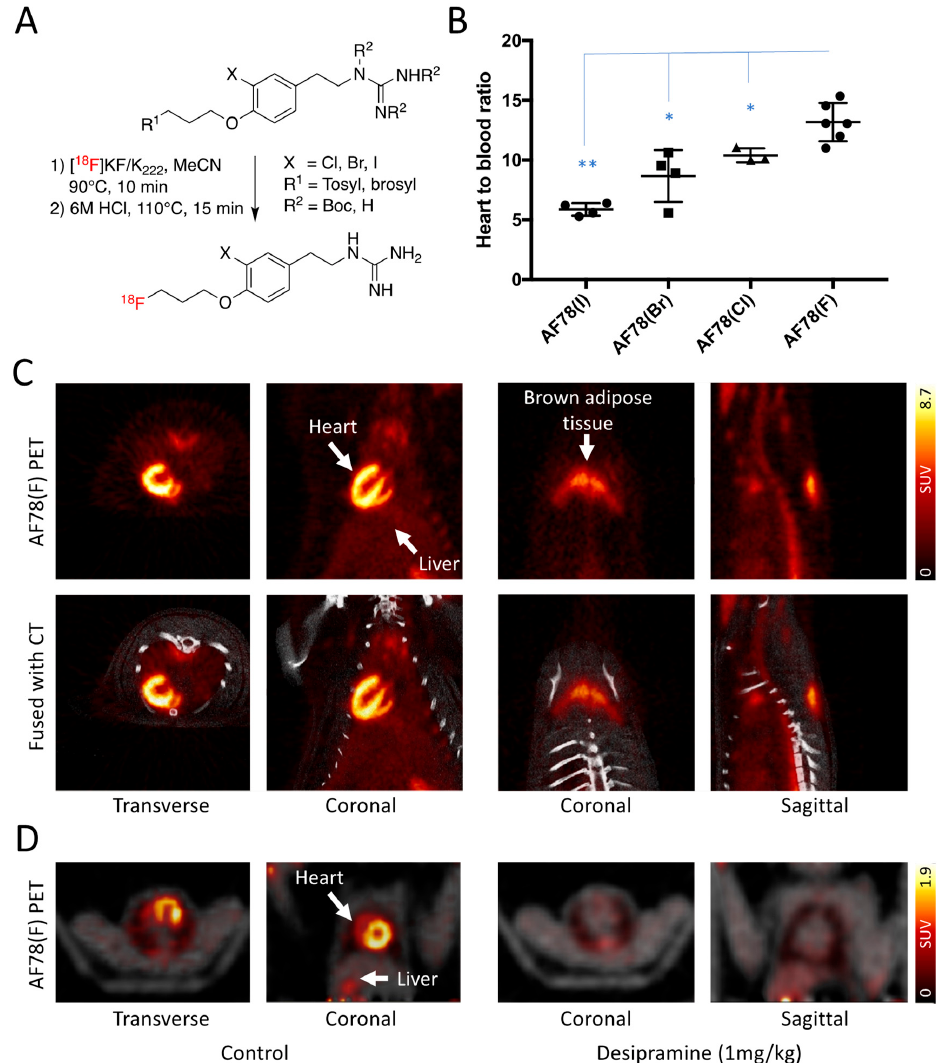
Figure 2. ( A ) Procedure for radiolabeling NET-targeting radiotracers using a one-pot two-step protocol where a radiofluorination was followed by the removal of Boc protecting groups under acidic conditions. ( B ) In vivo biodistribution experiments using radiolabeled tracers demonstrated that the heart-to-blood ratios agree well with the competitive cellular uptake assay, with AF78(F) showing the highest cardiac uptake. * p ≤ 0.05; ** p ≤ 0.01. ( C ) Fused PET/CT images of the cardiac ( left ) and brown adipose tissue ( right ) uptake of [ 18 F]AF78(F) in healthy rats. ( D ) PET images (fused with transmission scan) with and without NET blockade with desipramine (1 mg/kg, i.v., 10 min before radiotracer injection) in non-human primates (NHPs). Homogeneous cardiac [ 18 F]AF78(F) uptake can be reversed by pretreatment with desipramine. Cardiac imaging in rats and NHPs are generated from unpublished data using similar protocol as published previously. For further detailed kinetics in NHPs, please refer to